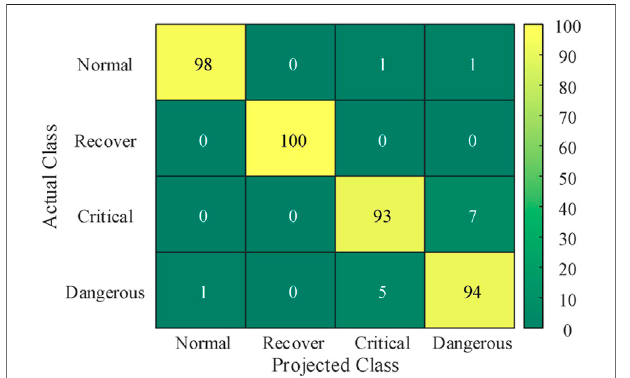
FIGURE 6 | Projection results of CNN.